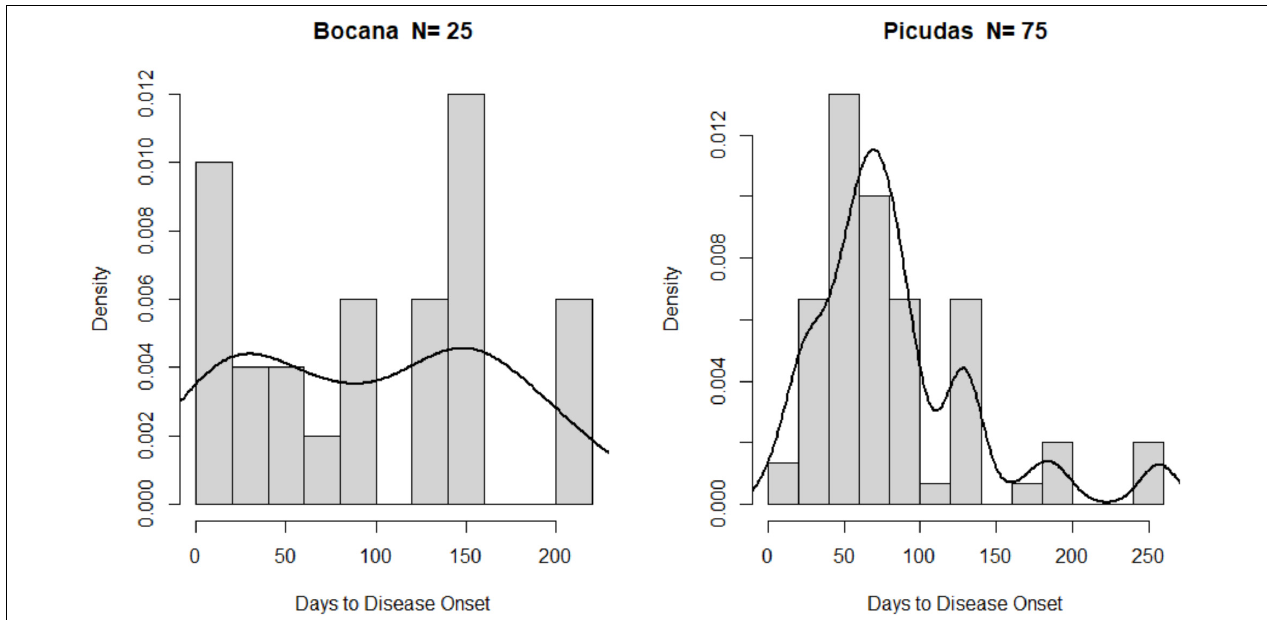
FIGURE 6 | Kernel density estimators (solid black line) show the multimodal distribution of time to white sign onset data. Histogram with 10 breaks to simulate data distribution for the 10 months of the study.